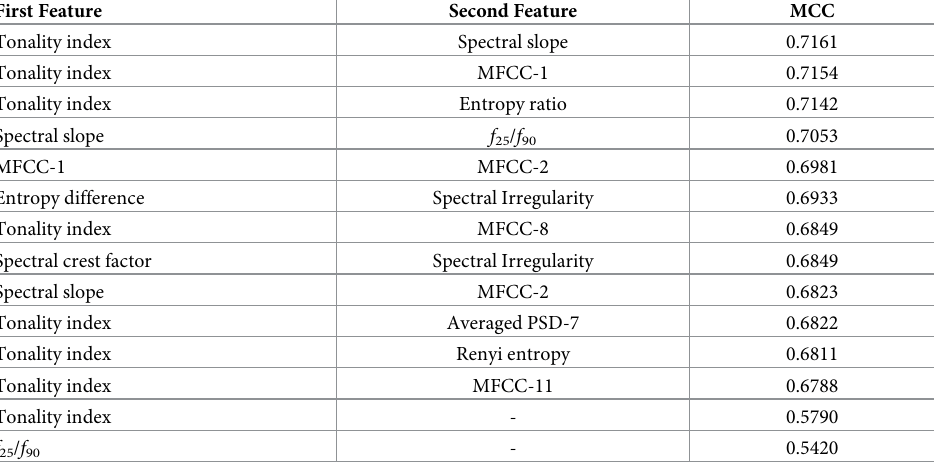
Table 10. MCC of the best pairs of features for wheeze and normal sound classification using logistic regression on the Test-Set.